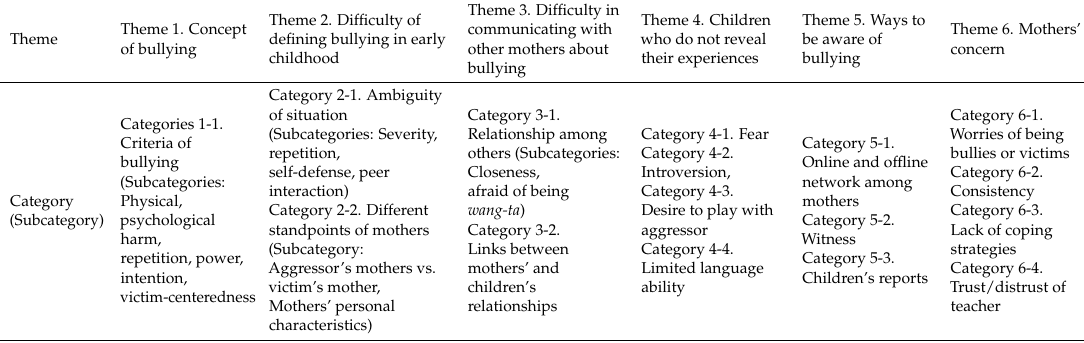
Table 2. Themes and categories (subcategories) that emerged from the analysis of mothers’